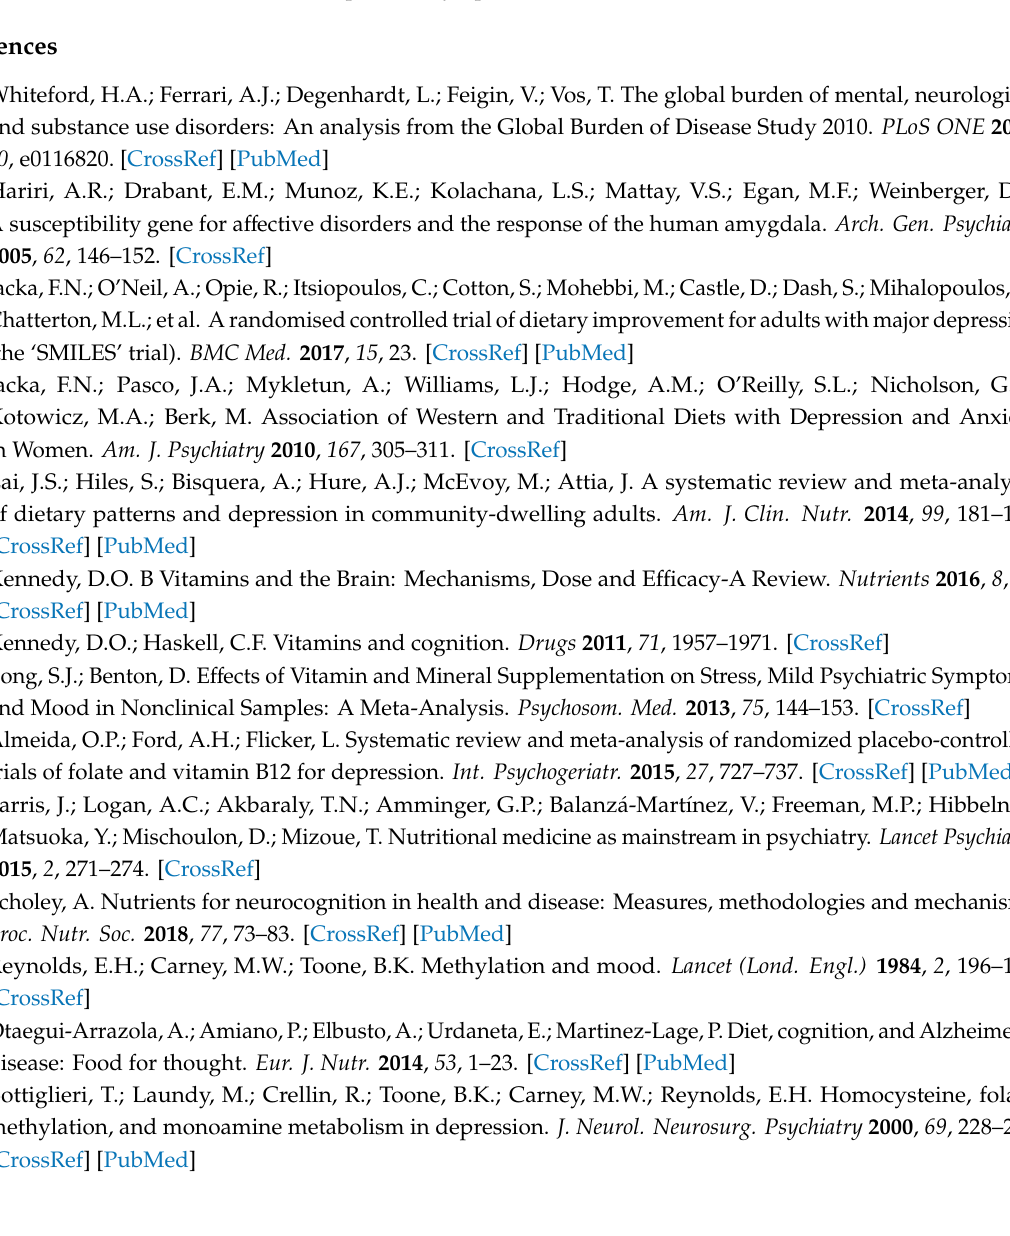
Figure A1. Depressive symptoms with outliers included.